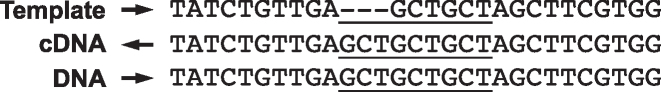
Notable 3-base insertion observed at position 219 in the reference sequence DNA-2. The first- and second-strand reads (mapped to the reference sequence, top) show a 3-base GCT insertion after a run of GCT repeats. Arrows indicate the direction of the original strand.